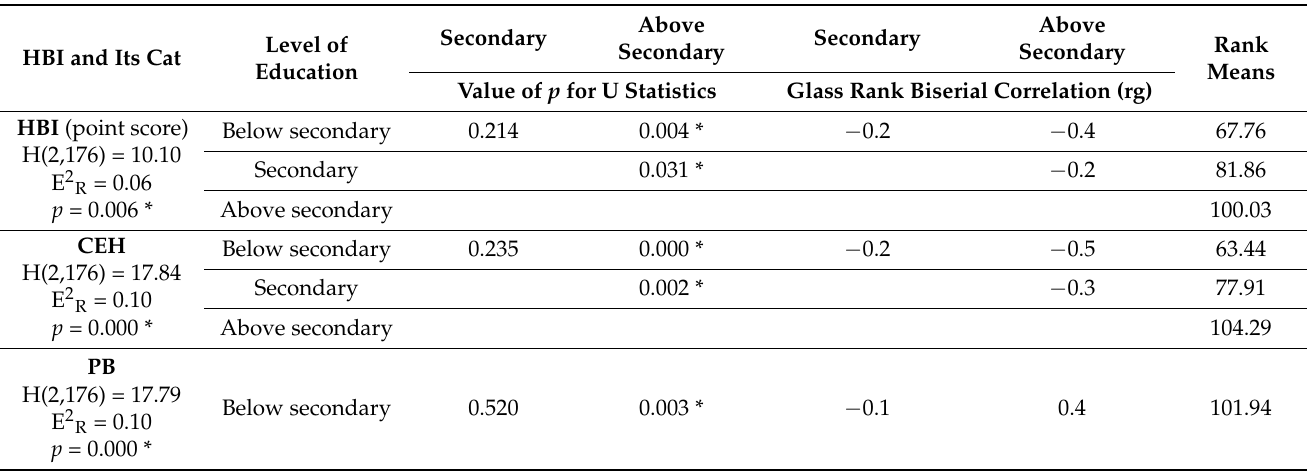
Table 5. Health behaviors of people practicing wheelchair basketball, wheelchair rugby and rowing depending on the level of education (the H test, E 2 R , the U test, rg).